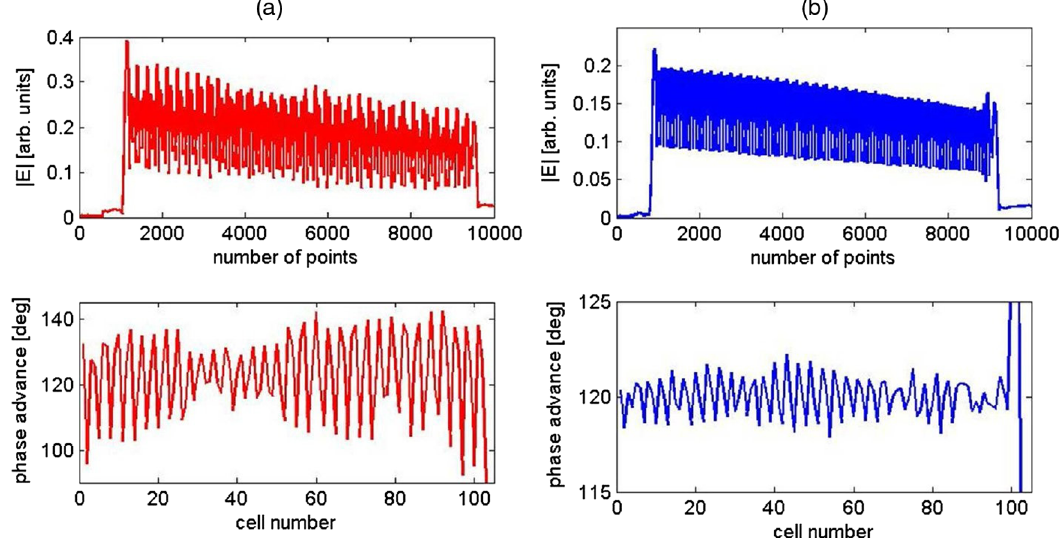
FIG. 11. Magnitude (upper plots) and phase advance per cell (bottom plots) of the prototype accelerating structure before (a) and after (b)